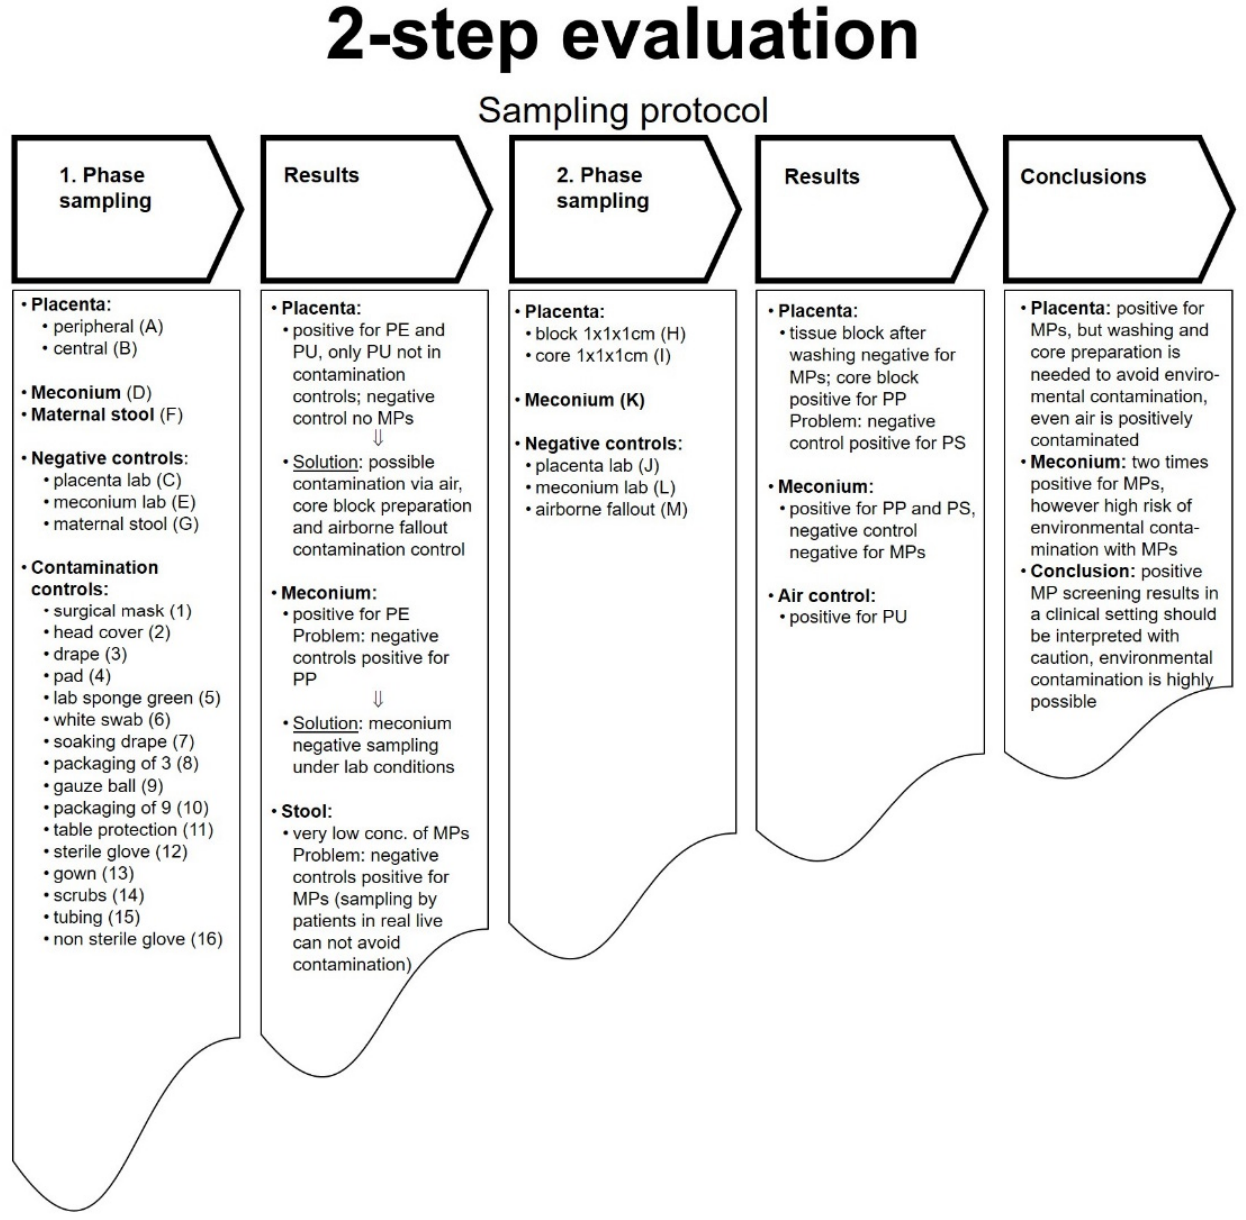
Figure 2. 2-step evaluation protocol. In phase 1, placental tissues, meconium, and maternal stool, negative controls, and contaminations controls were collected and analyzed for MPs. Negative controls include testing for MPs > 50 µm of the instruments used during the preparation of the tissues (placenta, meconium, maternal stool) without the actual tissues. To rule out possible contamination with plastic during the sampling and preparation steps, in phase 2, the placenta blocks were either intensively washed or only the “core” placental tissue was collected. Next to meconium, airborne fallout was sampled.